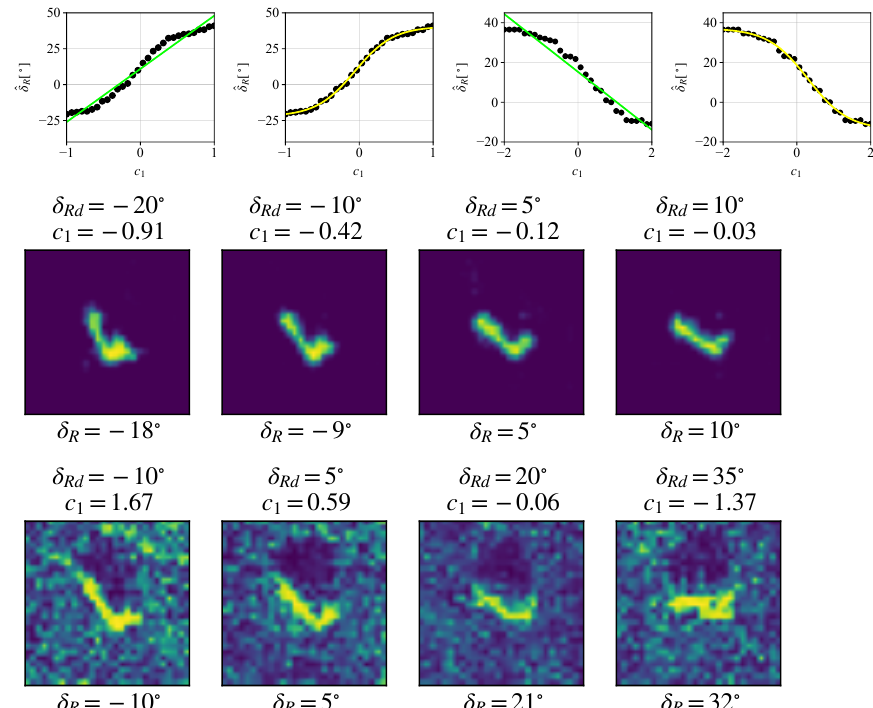
Figure 13. The results for the estimated and modeled rotation angle for the SAR images synthesized by the InfoGAN trained with real SAR images. The rotation angles in SAR images as a function of the latent code, c 1 , measured by cross-correlation (black dots) and the estimated values with a linear model (green line) ( top-left ). The rotation angles in SAR images as a function of the latent code, c 1 , measured by cross-correlation (black dots) and the estimated values with a nonlinear model (yellow line) ( top-right ). The synthesized SAR images using c 1 calculated by (26) for four desired rotation angles, δ Rd = − 20 ◦ , − 10 ◦ , 5 ◦ , 10 ◦ ( bottom row ). The estimated rotations of the synthesized SAR images, δ R ( k ) , are calculated using